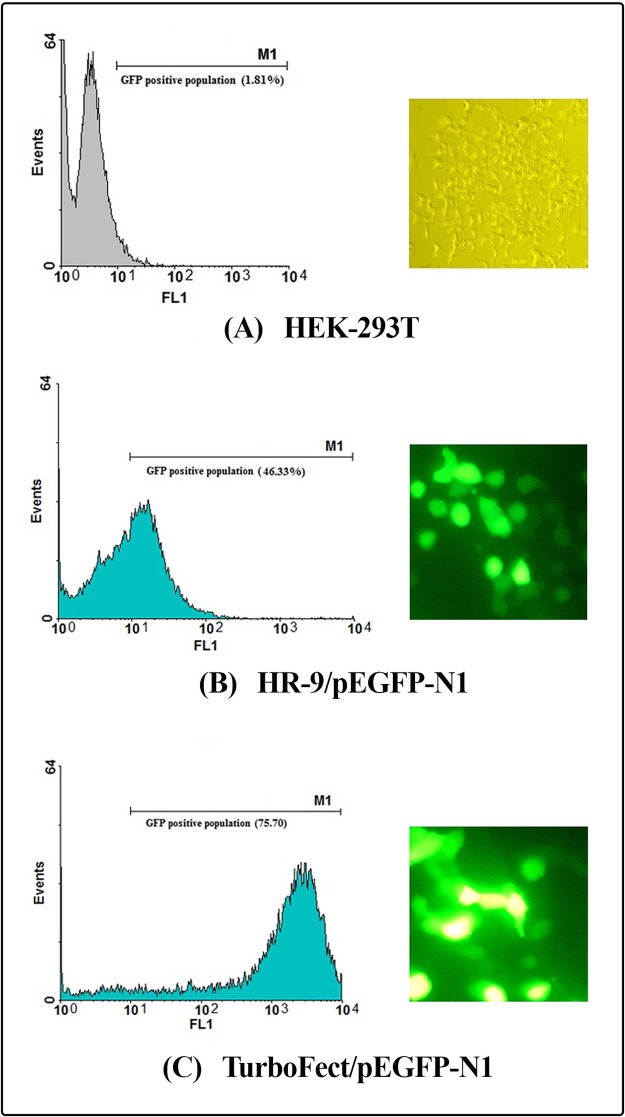
Transfection efficiency of the CPP/DNA complexes using flow cytometry and fluorescence microscopy.(A) HEK-293T as a negative control, (B) the HR9/pEGFP-N1 complexes, (C) the TurboFect/pEGFP-N1 complexes.